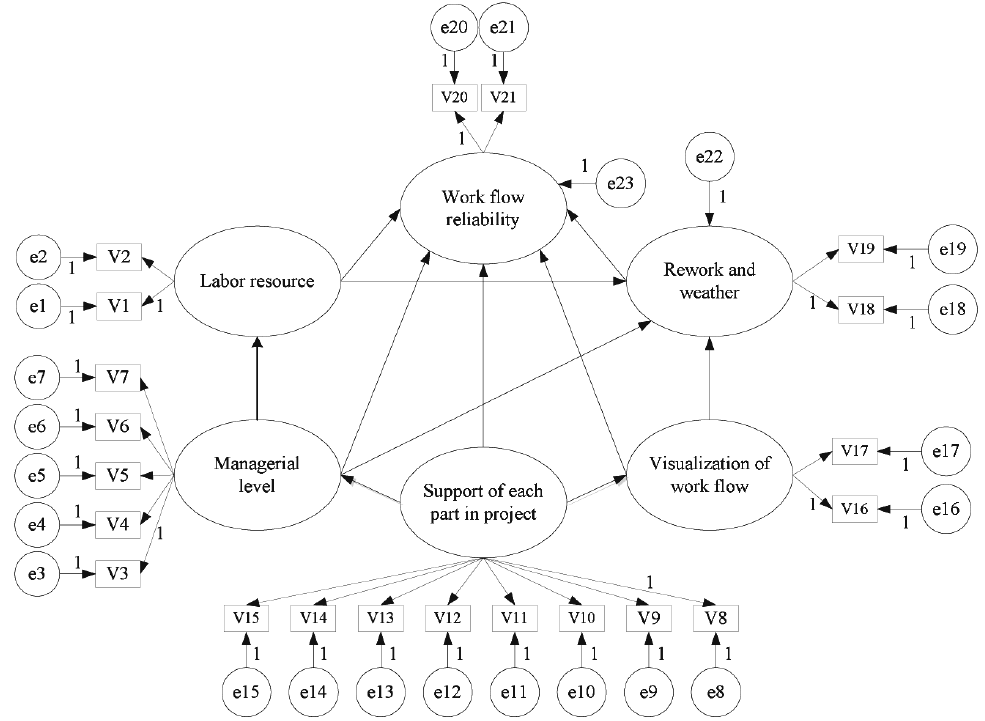
Fig. 2. Initial SEM of the interrelationship framework between work flow reliability and critical factors